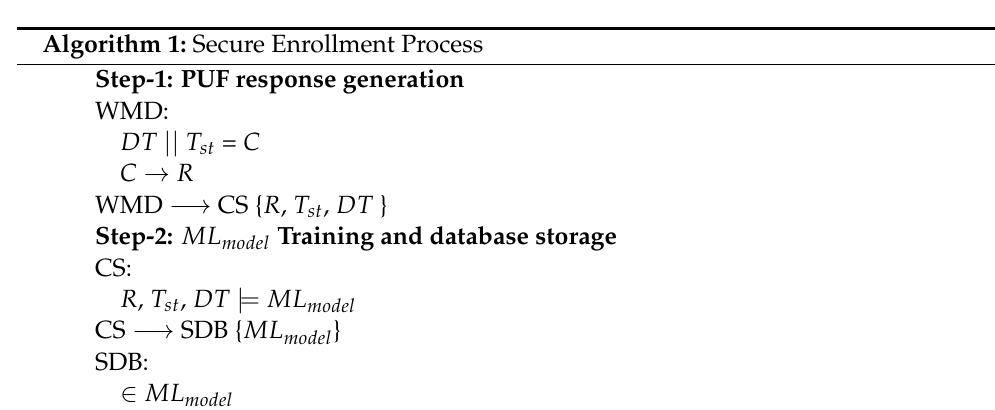
Figure 7. Enrollment Process.